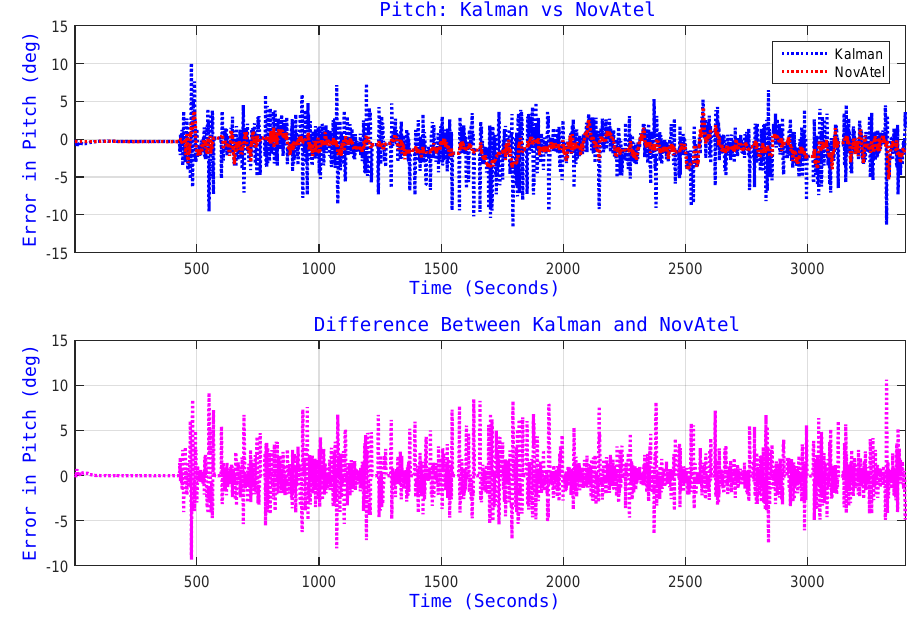
Figure 11. (Top) Performance of estimated pitch angle versus the reference (NovAtel) for the Kingston trajectory. The bottom plot shows the difference between the two